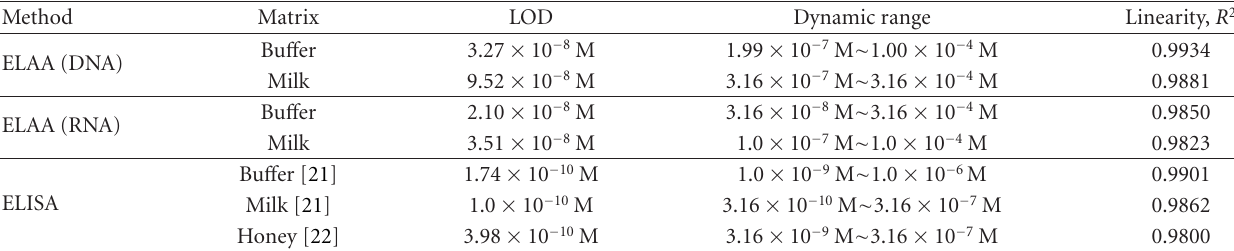
Table 3: Analytical data for TC aptamer assay (ELAA) compared with TC antibody assay